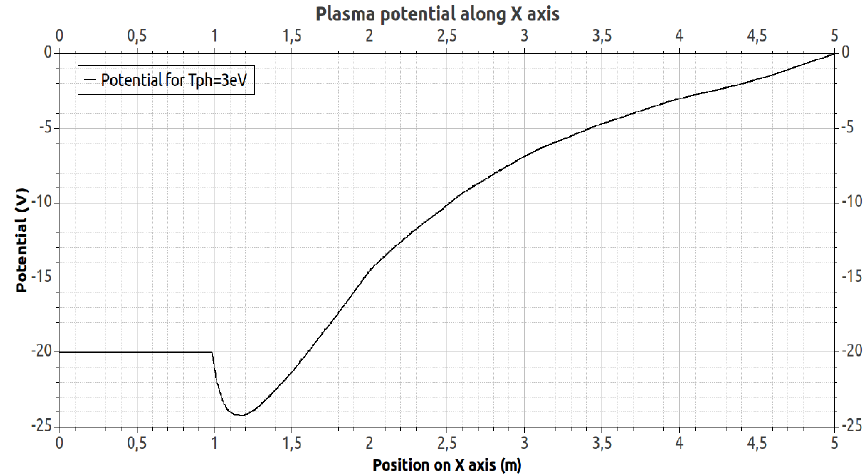
Fig. 7. Cross comparison simulation B (SPIS): plasma potential along the x-axis, showing the existence of a − 4V potential barrier on the side of the